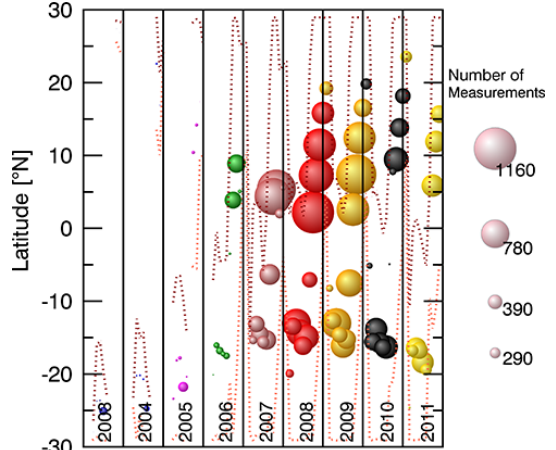
Figure 1. Number of OSIRIS mesospheric night mode scans for each month between 2003 and 2011 carried out on the ascending leg of the satellite’s flight path and with an SZA > 101 ◦ . We show one circle for each month; while the size of the circle represents the number of measurements in this months in the 30 ◦ S to 30 ◦ N latitude band, the position of the circle corresponds to the average latitude of the measurements in this months. The dotted lines show the minimum and maximum latitude of the available OSIRIS mea- surements.